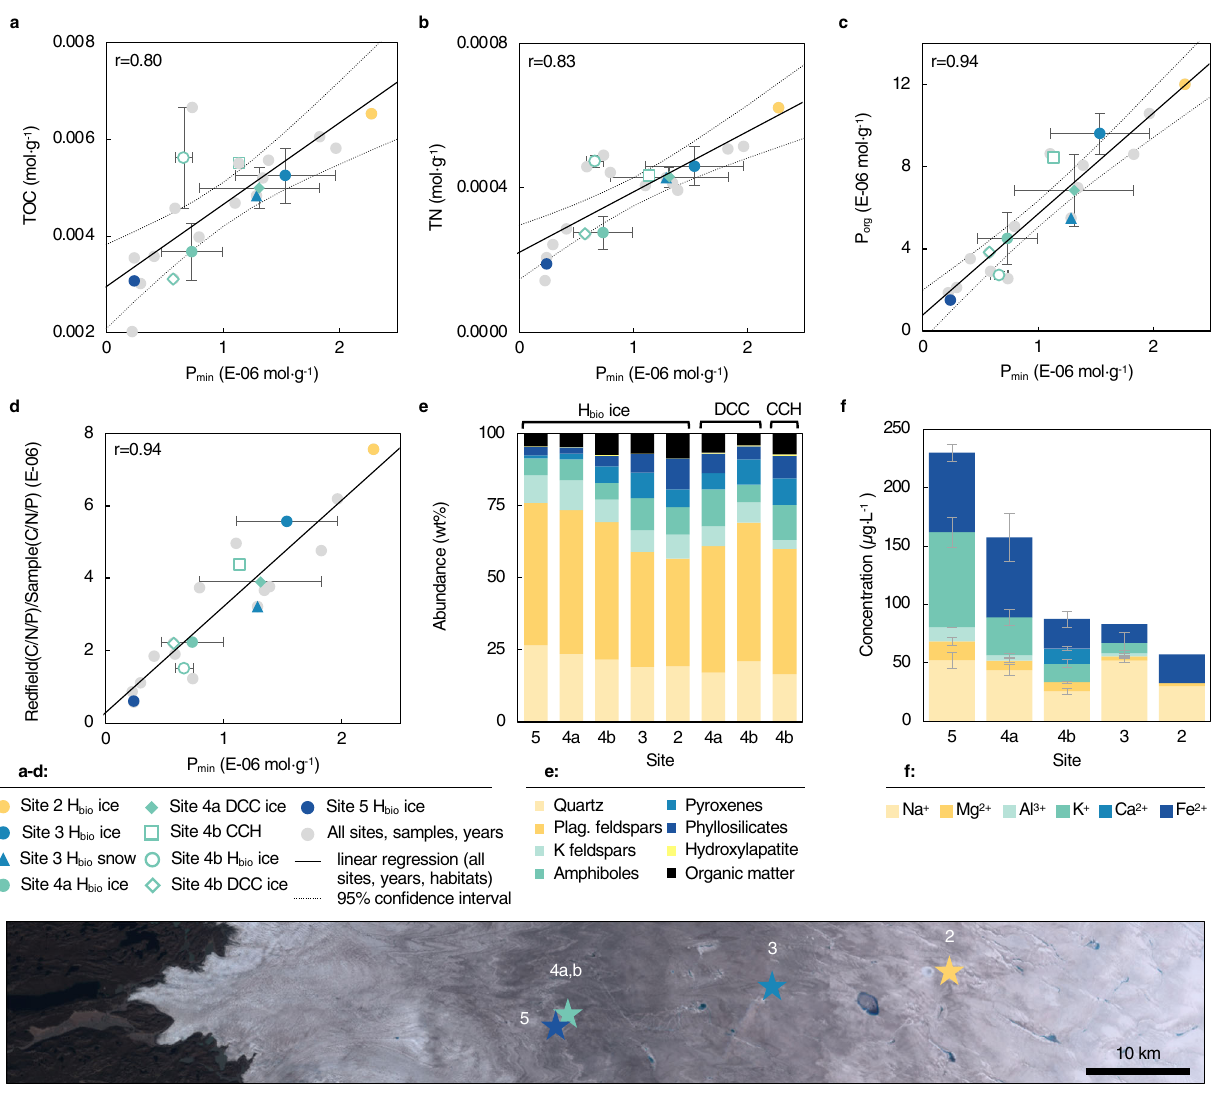
Fig. 3 Dark Zone particulate matter nutrient concentrations, mineralogy, and major cation concentrations in associated meltwater. P min concentration in particulates plotted against a total organic carbon (TOC), b total nitrogen (TN), c organic phosphorus (P org ), and d molar C:N:P org ratio normalized to the Red fi eld ratio (C:N:P 106:16:1). Linear regression and r-values (Pearson ’ s product-moment correlation) correspond to all data points from all sites (gray dots). e Relative mineral and organic matter abundances across the ablation zone, including hydroxylapatite (bright yellow); f major cation concentrations in meltwater from H bio ice across the ablation zone. H bio ice: high algal biomass ice; DCC ice: dispersed cryoconite ice; CCH: cryoconite hole. In a – d : colored points: mean values for different sites, habitats, and years, ±SE (2016: solid fi ll; 2017: white- fi ll); solid line: linear regression; thin dashed lines: 95% con fi dence interval. Site 2 H bio ice n = 1; Site 3 H bio ice n = 2; Site 3 H bio snow n = 1; Site 4a H bio ice n = 5; Site 4a DCC ice n = 2; Site 4b H bio ice n = 2;